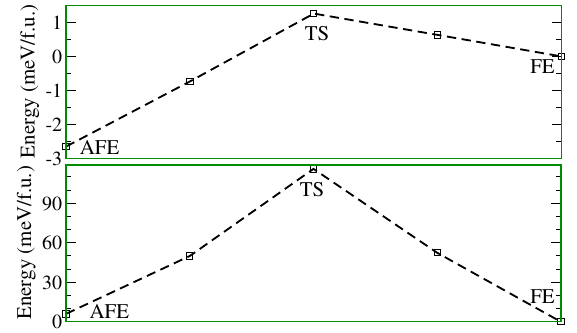
FIG. 5 Energy barrier from the FE state to the AFE (i.e., AFE ab − FE c ) state. The upper panel shows the zero-strain case, while the lower panel shows the case when the compressive epitaxial strain is